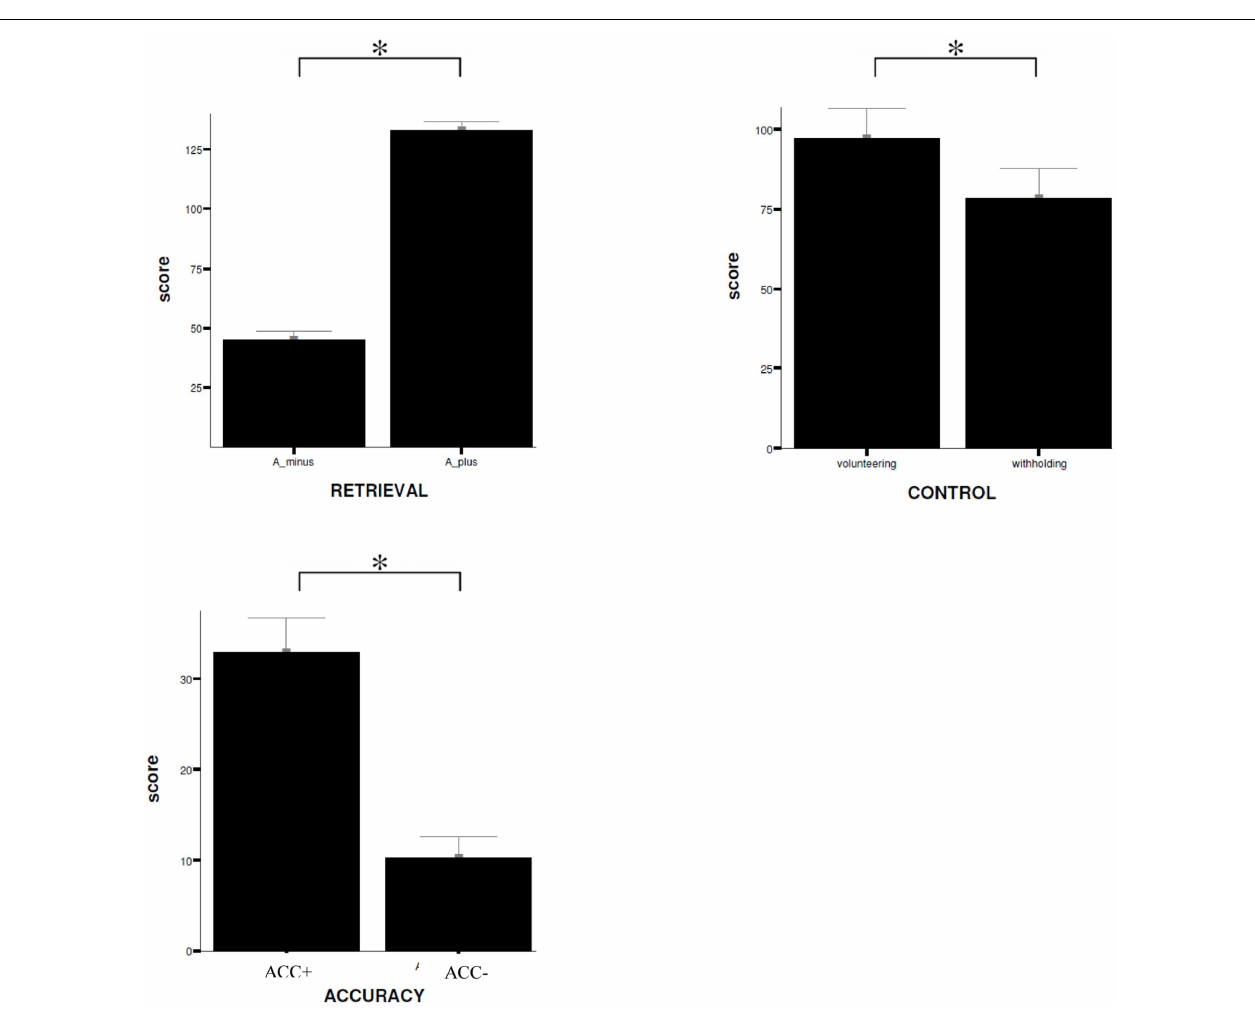
withholding; SD, standard deviation; *trend of statistical significance ( p < 0.05, uncorrected). A_ minus = incorrect answering; A_ plus = correct